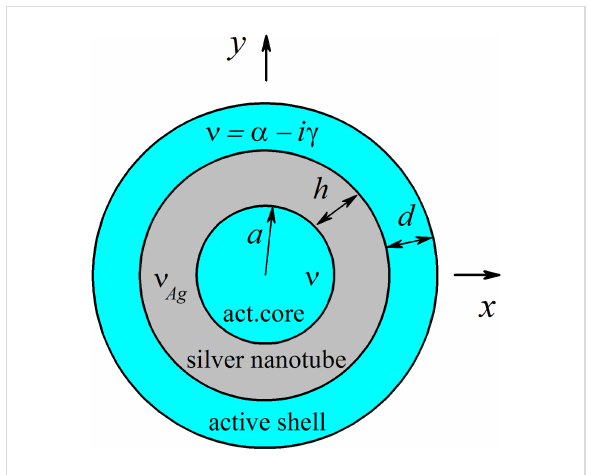
Figure 1: Cross section of a nanolaser built on a silver nanotube with an active core and an active shell.